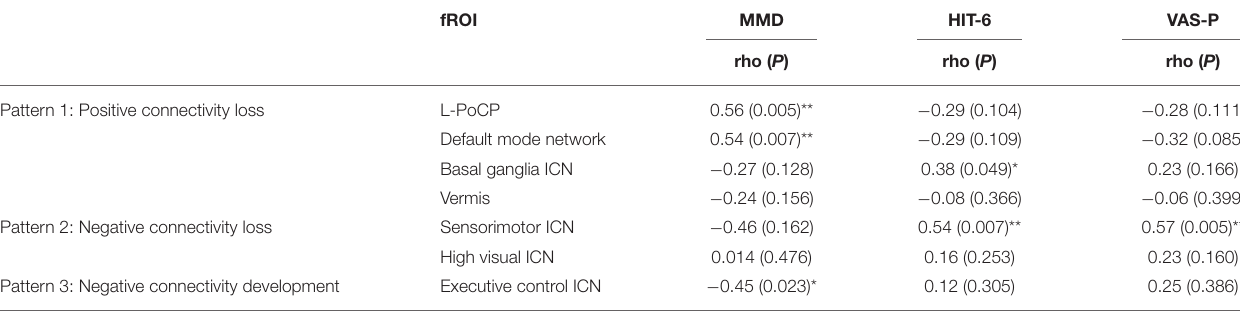
TABLE 3 | Correlations between PAG RS-FC with migraine clinical measures scores in MS + M patients. fROI MMD HIT-6 VAS-P